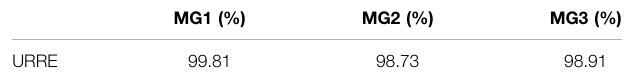
TABLE 4 | Comparison of energy utilization.